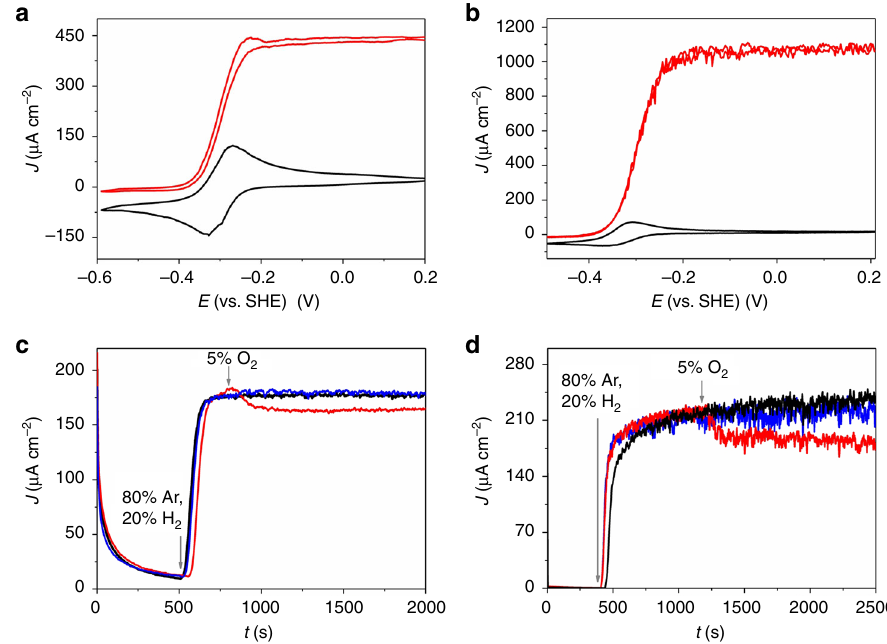
Fig. 2 Electrochemical characterization of the bioanode. Cyclic voltammetry ( a , b ) and chronoamperometry ( c , d ) of glassy carbon electrodes modi fi ed with the polymer multilayer system comprising an underlying P(N 3 MA-BA-GMA)-vio/hydrogenase layer (drop cast, a , c : [NiFe] hydrogenase from Desulfovibrio vulgaris Miyazaki F, Dv MF-[NiFe], b , d : [NiFeSe] hydrogenase from Desulfovibrio vulgaris Hildenborough, Dv H-[NiFeSe]) and an outer protection layer based on P(SS-GMA-BA)/GOx/CAT (drop cast). Working electrolyte: 0.1 M phosphate buffer (pH 7.4), a and b : scan rate: 10 mV s − 1 ; black traces: 100% argon, red traces: 100% H 2 ; c , d : applied potential: + 160 mV vs. standard hydrogen electrode (SHE); black traces: 80% Ar and 20% H 2 ; red traces: 75% Ar, 20% H 2 and 5% O 2 without glucose, blue traces: 75% Ar, 20% H 2 and 5% O 2 with glucose in solution (50 mM). Gray arrows in c and d indicate a change of the gas feed composition. P(N 3 MA-BA-GMA)-vio = poly(3-azido-propyl methacrylate- co -butyl acrylate- co -glycidyl methacrylate)-viologen; P(SS-GMA-BA) = poly(4-sytyrenesulfonate- co -glycidyl methacrylate- co -butyl acrylate); GOx; glucose oxidase, CAT;